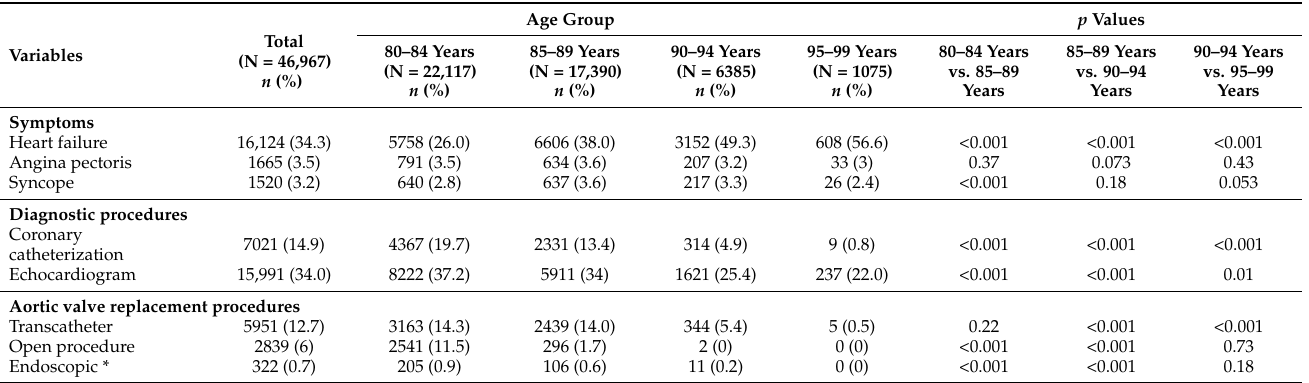
Table 2. Symptoms, diagnostic procedures and therapeutic approach in very old inpatients with aortic stenosis, by age